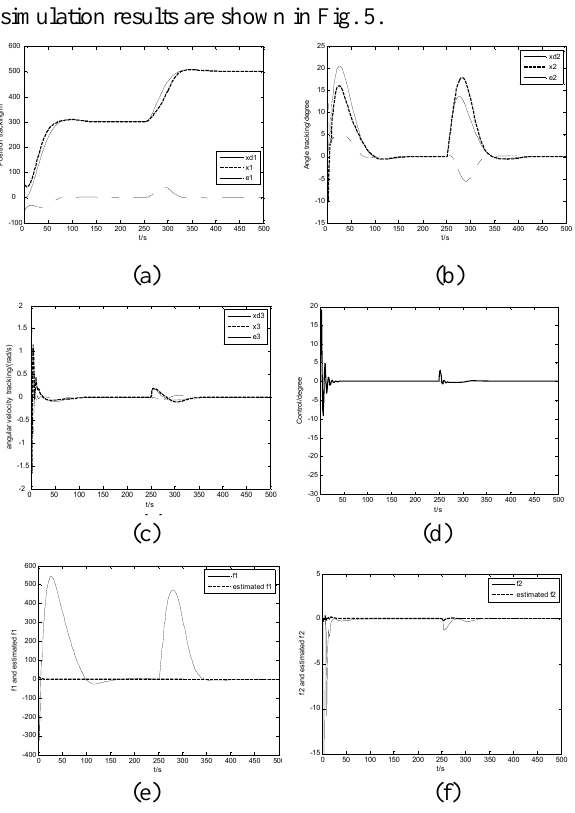
Fig. 5. Simulation results of the DES path tracking in case II. (a) s way displacement (b) yaw angle (c) yaw rate (d) control rudder angle (e)